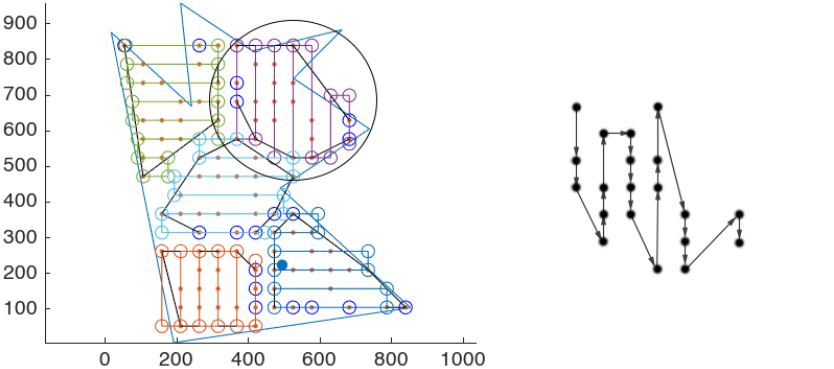
Figure 2. Plot of HPP clusters and their associated route plans. The blue dot signifies the depot location. The circled section is shown on the right with the resulting path for that